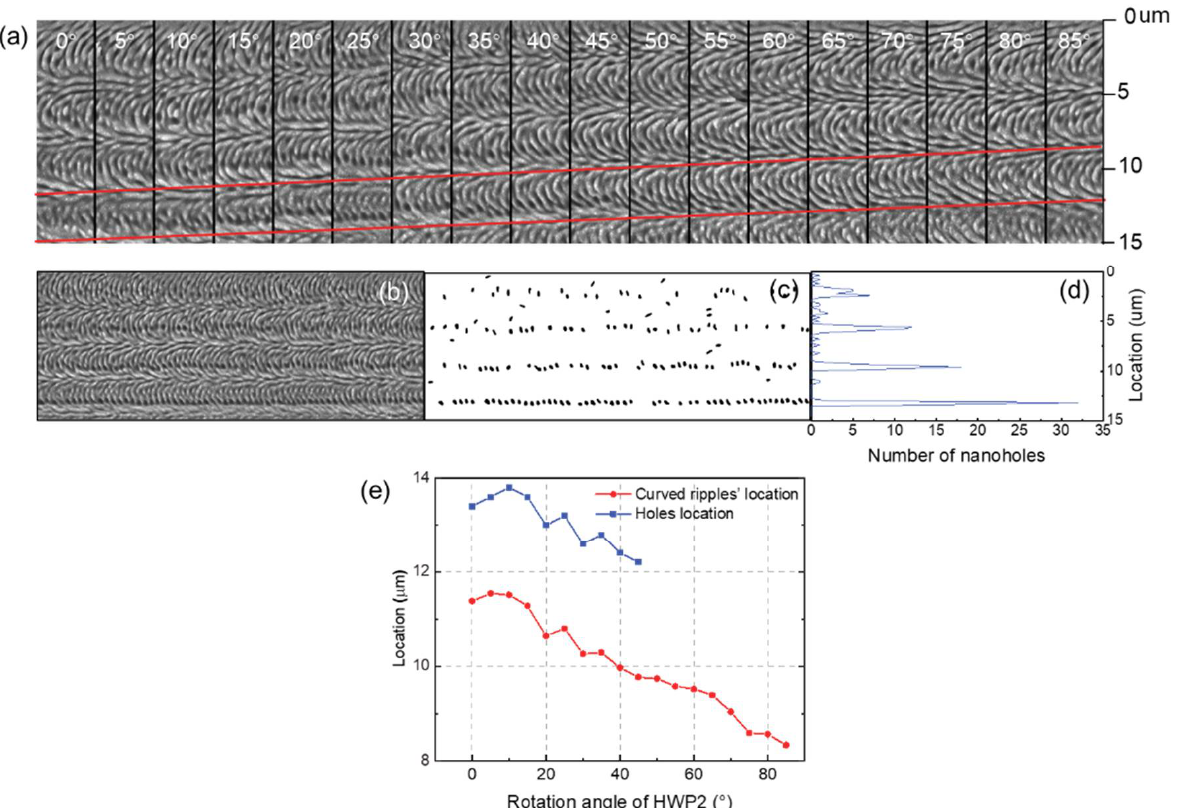
Figure 4. ( a ) Nanostructures on the tungsten surface fabricated by non-cylindrical femtosecond vector beam when the half-wave plate (HWP2 in Figure 1) was rotated at different angles ranging from 0 to 85°; 0° indicates the fast axis of HWP2 was parallel to the x -axis in Figure 1. ( b ) Nanostructures fabricated when the angle of HWP2 was 25°. ( c ) Nanohole distribution extracted from ( b ). ( d ) Number of nanoholes at different locations along the vertical direction. ( e ) Dependences of the locations of nanoholes (square dots) and the vertical laser polarization (circular dots) on the angle of HWP2.